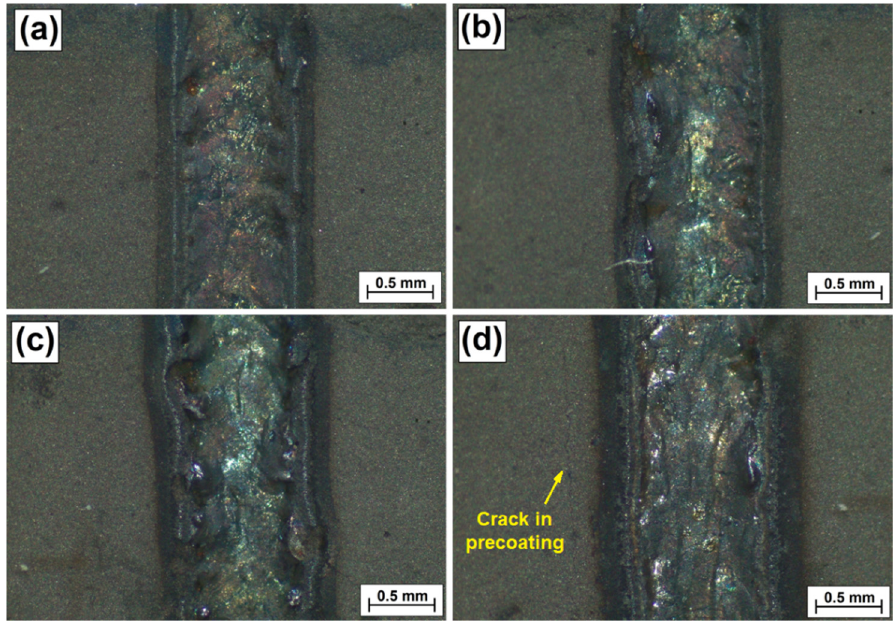
Figure 3. Surface condition of Fe/ZrC coatings—single laser tracks produced using laser beam power of 500 W ( a ), 700 W ( b ), 900 W ( c ) and 1100 W ( d ) .